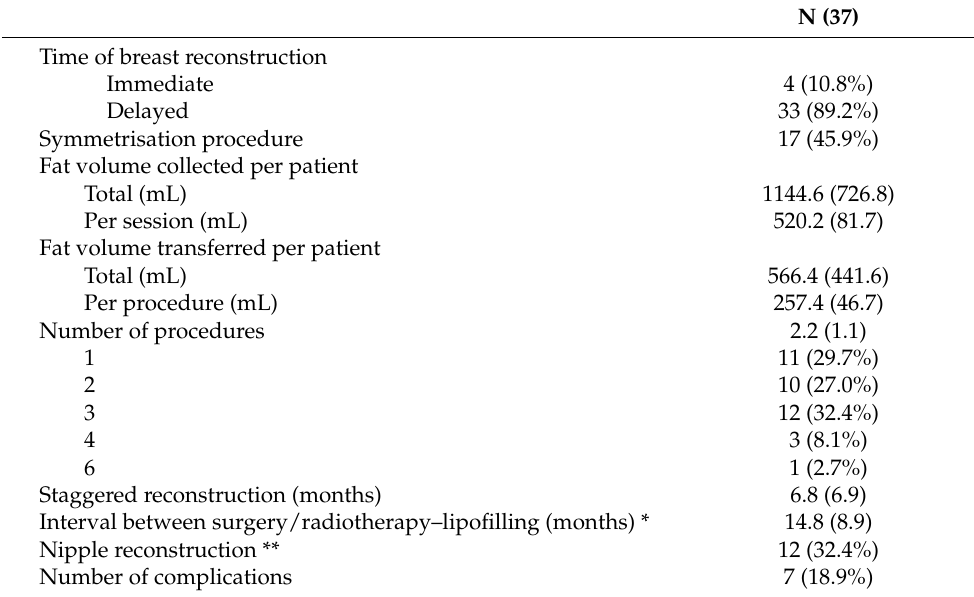
Table 3. Technical results of lipofilling procedure ( n =